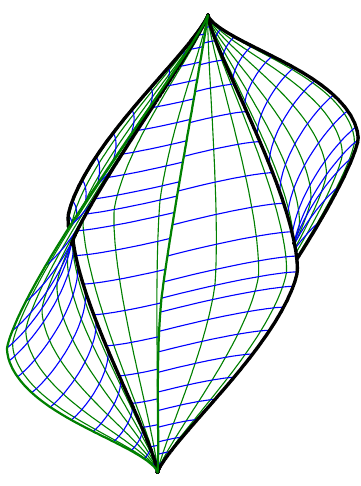
Figure 1. Part of a